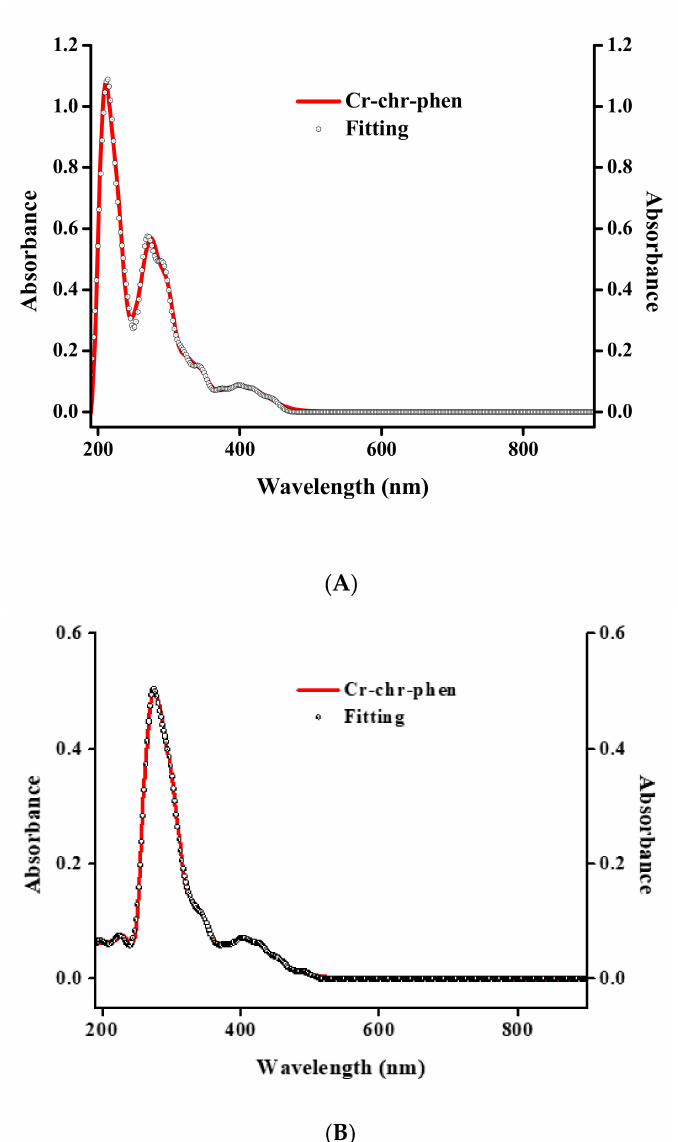
Figure 4. ( A ) UV-Visible spectrum (red line) and spectral fitting (circles) of compound 2 in methanol (10 − 5 M). ( B ) UV-Visible spectrum (red line) and spectral fitting (circles) of compound 2 in DMSO (10 − 5